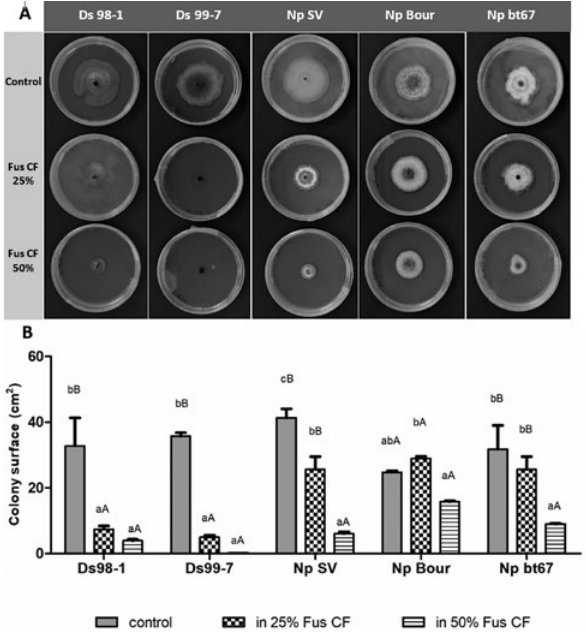
Figure 3. Biological control activity of the two different culture fil- trate aliquots of F. proliferatum strain Fus (Fus CF) against growth of Botryosphaeriaceae fungi at 7 dpi. In B), the ANOVA results (two-way + Bonferroli test) on mean colony areas (cm 2 ) indicated a different Fus CF effect, for species and strain. Columns accompa- nied by the same letters are not significantly different (lowercase, P ≤ 0.05, uppercase P ≤ 0.01).